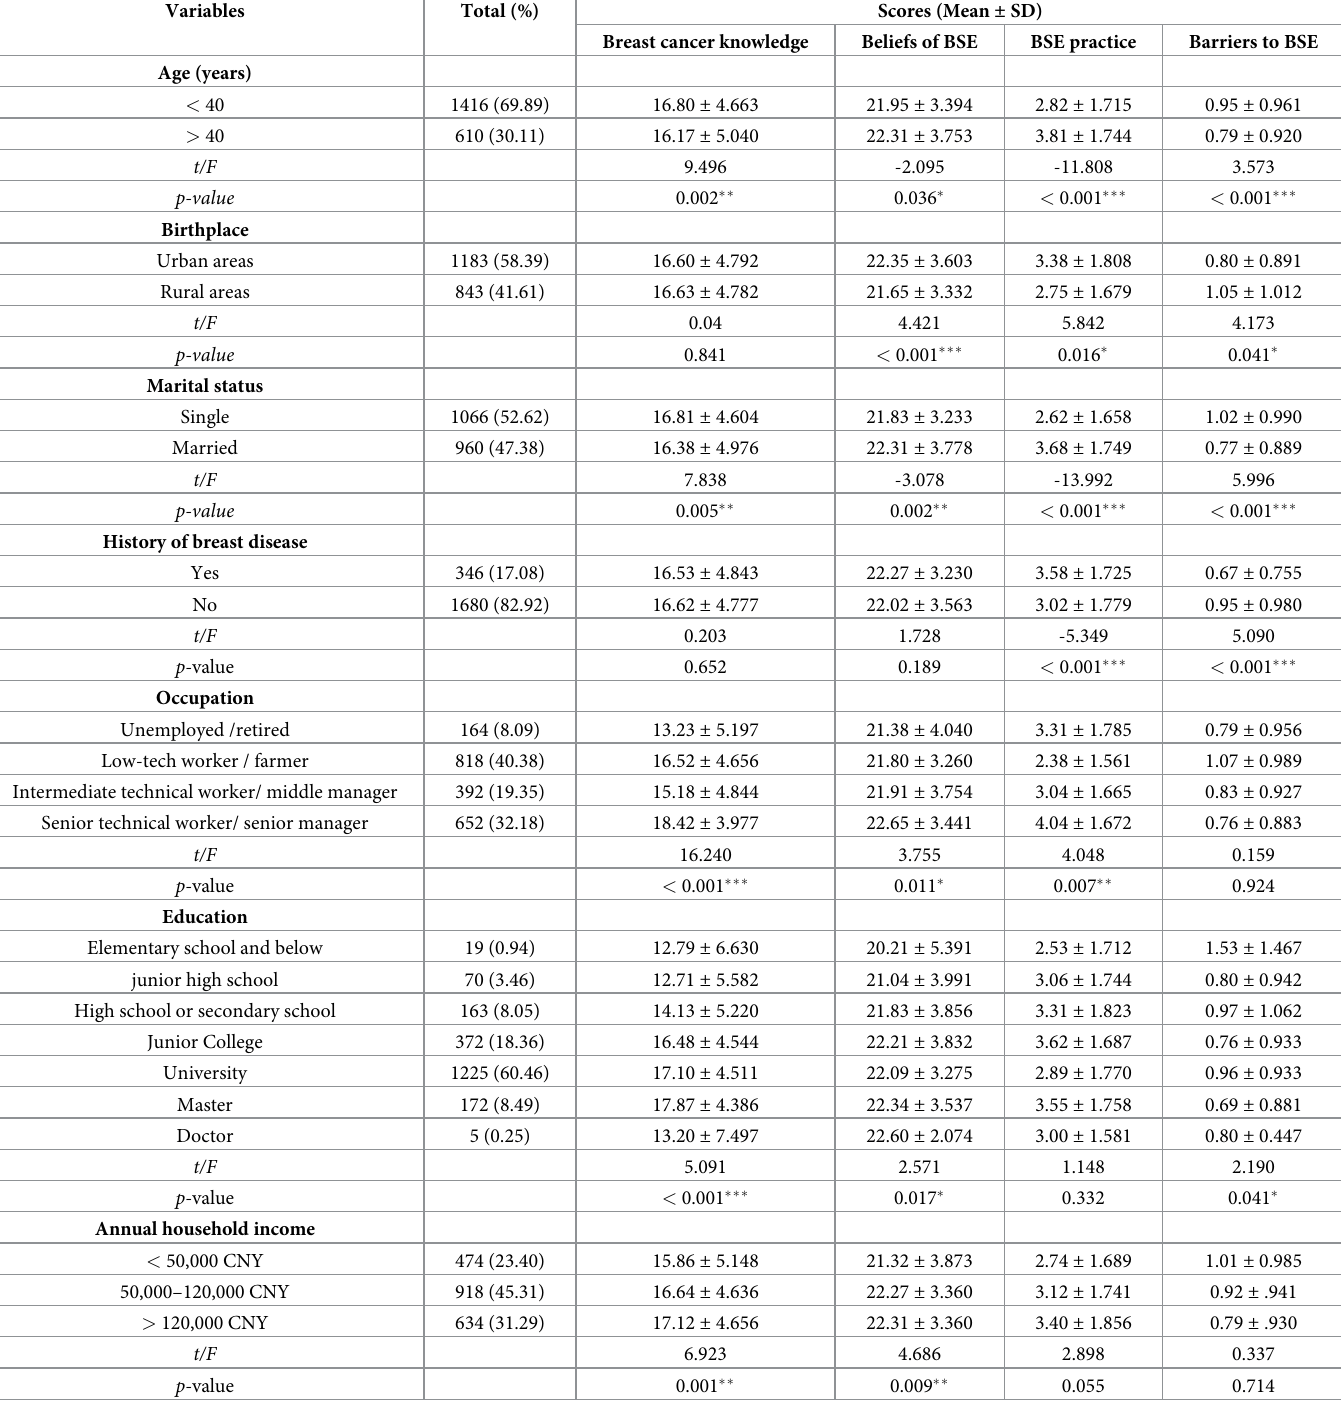
Table 1. Participants’ demographic characteristics (n =